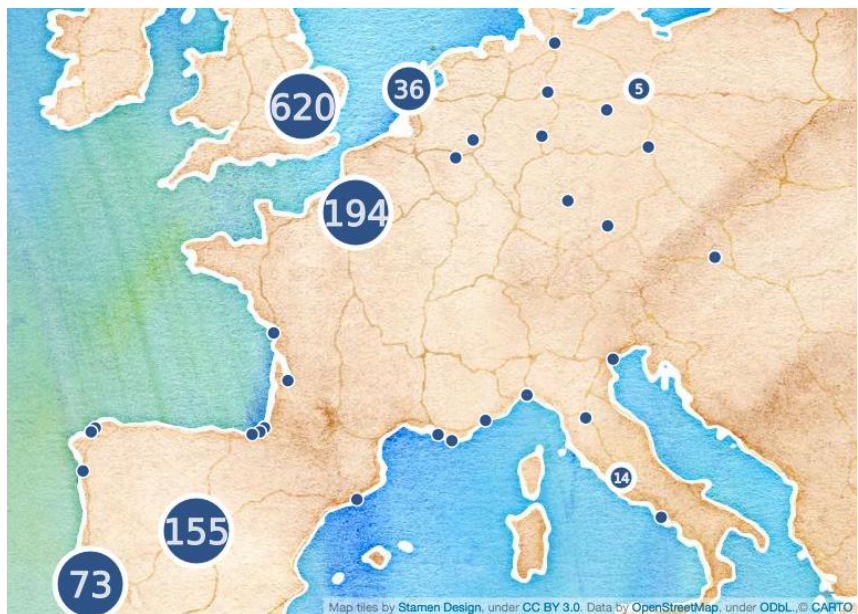
The origins of the Gazette articles that discuss Colonial America